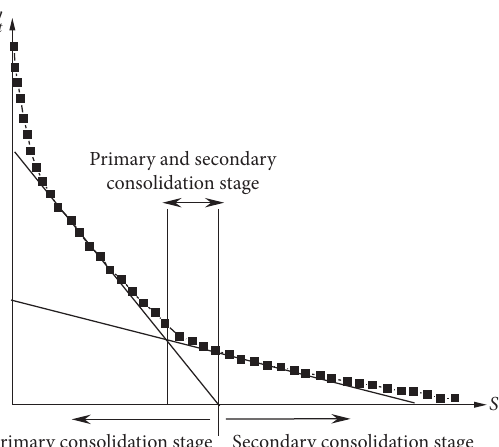
Figure 4: Relationship between settlement volume and settlement rate.